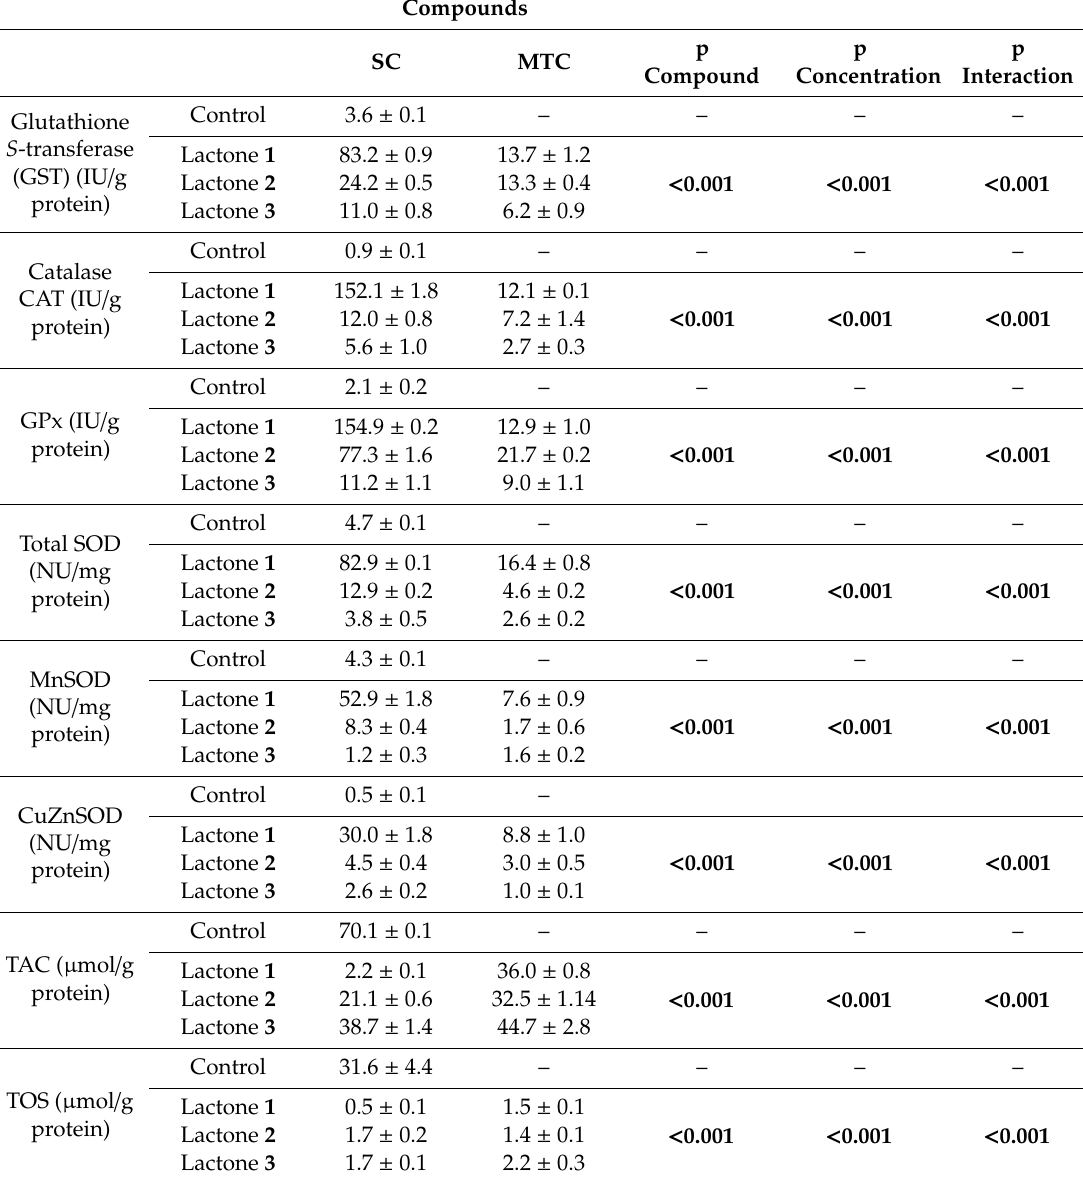
Table 3. The levels of concentration assessed in the NHDF cells line after exposition to lactones 1 – 3 . The table shows results of the two-way ANOVA analysis between compound, concentration, and simultaneous influence of individual factors on selected oxidative stress markers. The results are shown as mean values ± standard deviation. SC—starting concentration, MTC—minimal toxic concentration. Statistical significance was set at p < 0.05. Statistically significant values are